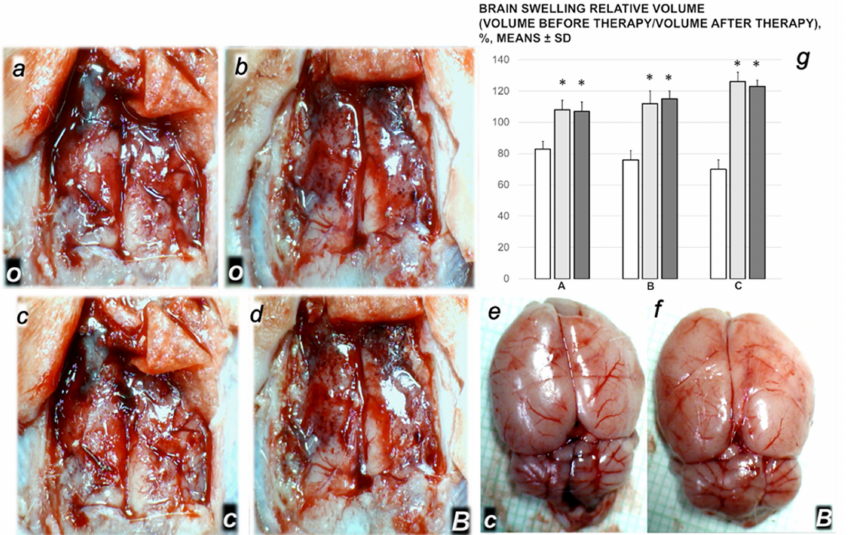
Figure 9. Brain swelling gross in vivo presentation in the rats with the occluded end of the superior mesenteric vein in the rats before the medication ( a , b , black letters) ( o , white letters). Further swelling progression ( c , black letters) at 15 min after they had received saline therapy ( c , white letters). Decreased swelling ( d , black letters) at 15 min after they had received BPC 157 therapy ( B , white letters). Swelling progression ( e , black letters) at 30 min after they had received saline therapy ( c , white letters). Decreased swelling ( f , black letters) at 30 min after they had received BPC 157 therapy ( B , white letters). Relative volume of the relative volume of brain swelling ( g ), volume before therapy/volume after therapy, %, in the rats with ligated superior mesenteric vein at 5 min (A), 15 min (B) and 30 min (C) ligation time. BPC 157 10 µ g/kg (light gray bars), 10 ng/kg (dark gray bars); saline 5 mL/kg (white bars)) given intraperitoneally at 1 min ligation time. Six rats/group/interval. Means ± SD, * p < 0.05, at least vs.